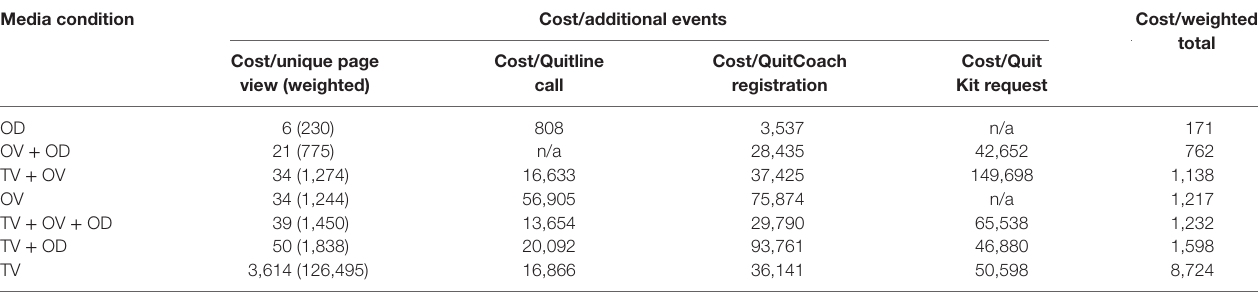
taBlE 4 | Cost-effectiveness of each media condition